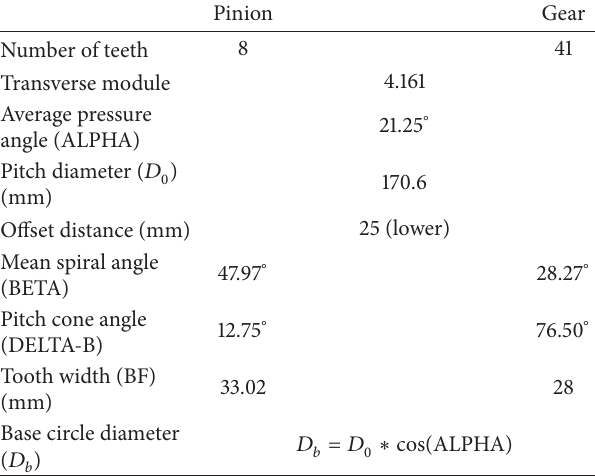
circular section) Table 2: Parameters of the pinion and gear. Pinion Gear